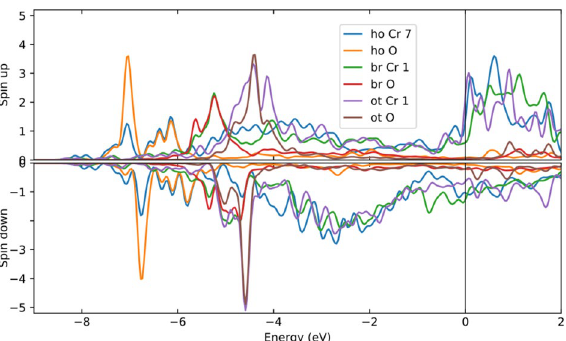
Figure 6. Comparison of the local densities of states of oxygen and chromium atoms calculated with a projection to an atomic basis located at the atomic sites. The labels ‘ho’, ‘br’ and ‘ot’ indicate whether the oxygen is at a hollow, bridge or on-top site. The second label tells the type of atom under consideration (Cr or O), and the number indicates the Cr position (see Fig. 1 for the site numbering). The horizontal axis is energy in eV relative to the Fermi energy, and the vertical axis is the DOS (both up and down spin channels) in arbitrary units.